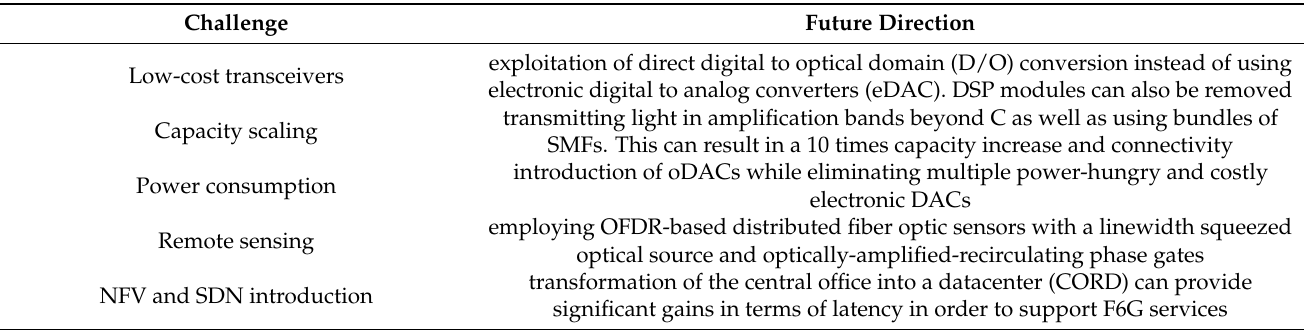
Table 13. Summary of the main technical challenges and the proposed future directions.